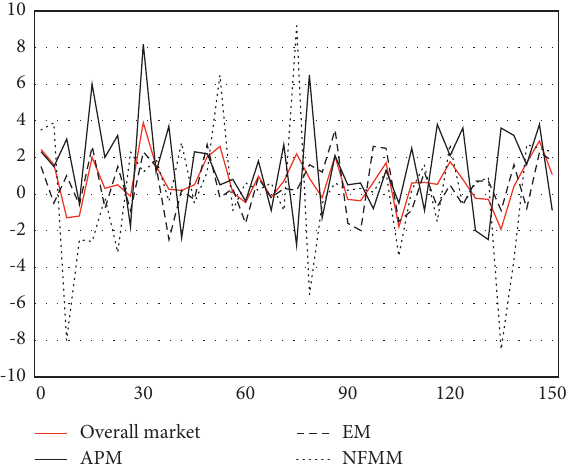
Figure 5: Comparison of the incomes of different NRC markets.